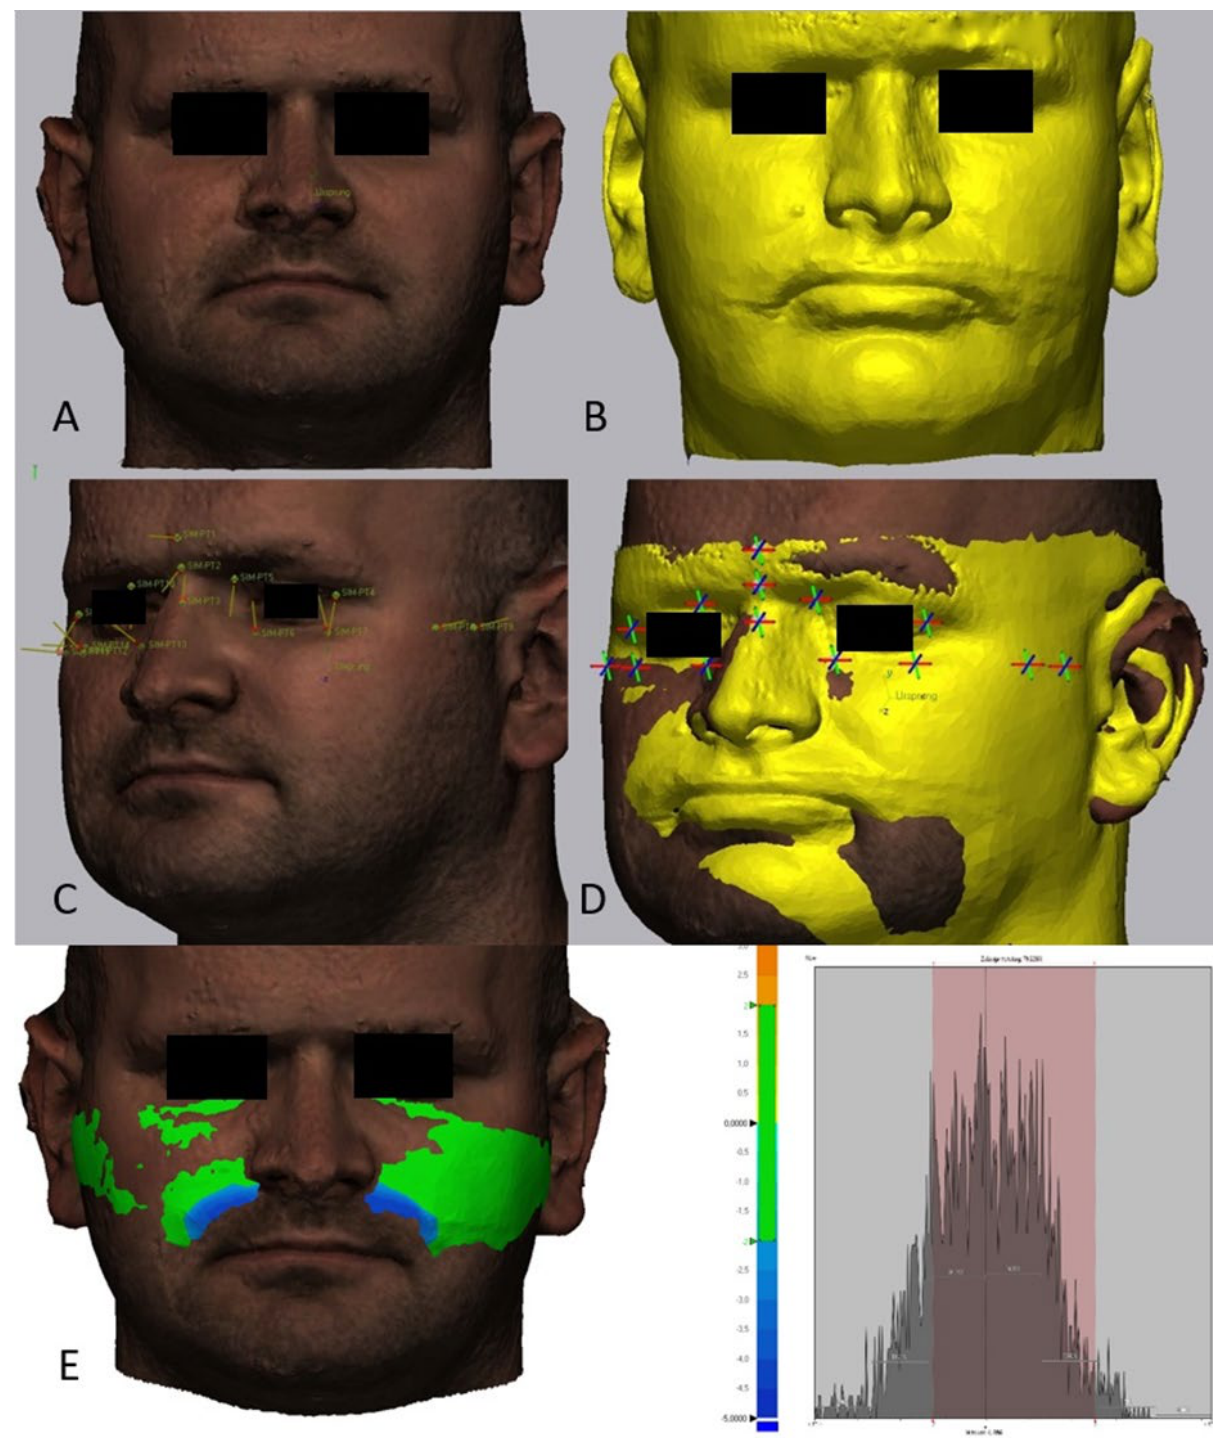
Figure 1. ( A ): Postoperative 3D scan, ( B ): Preoperative simulation of the postoperative soft-tissue (IPS CaseDesigner ® ) , ( C , D ): RPS-Alignment, using 15 pairs of reference points in the nasal, periorbital, and zygomatic area of the face, ( E ): An example of the surface congruence for the anatomic area (upper cheek) illustrated with a colour-coded error map.